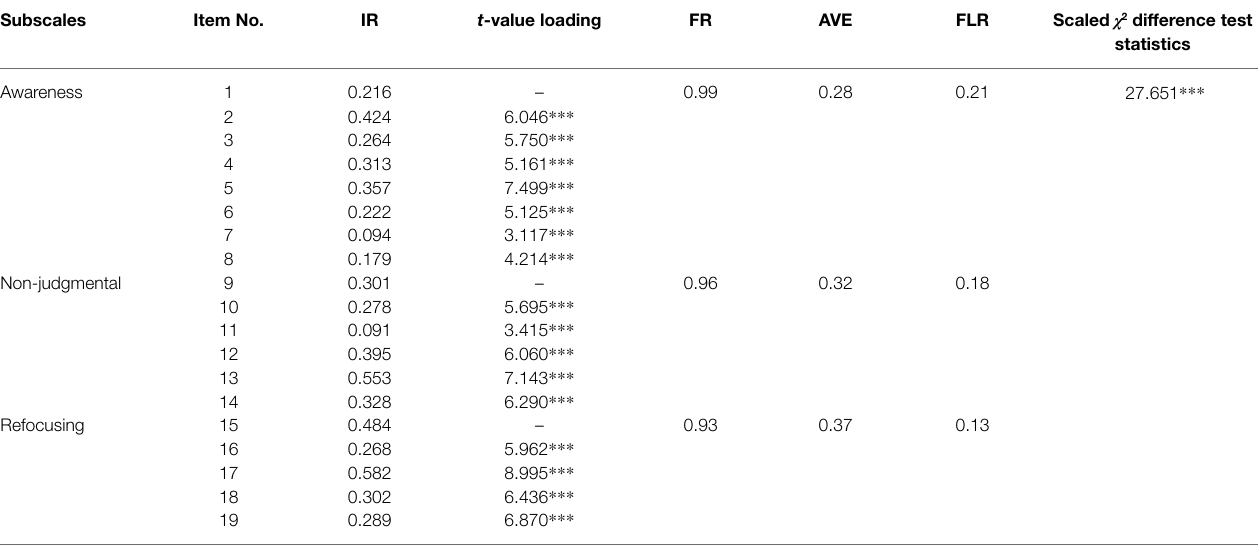
TABLE 1 | Inner-method convergent and divergent measures within MIS-D (German translation). Subscales Item No.